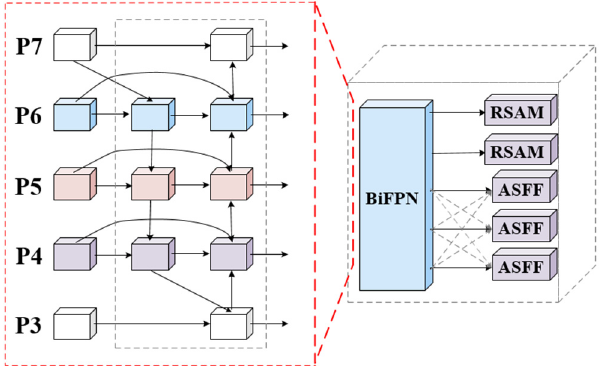
Figure 3. The structure of weighted bi-directional feature pyramid network.